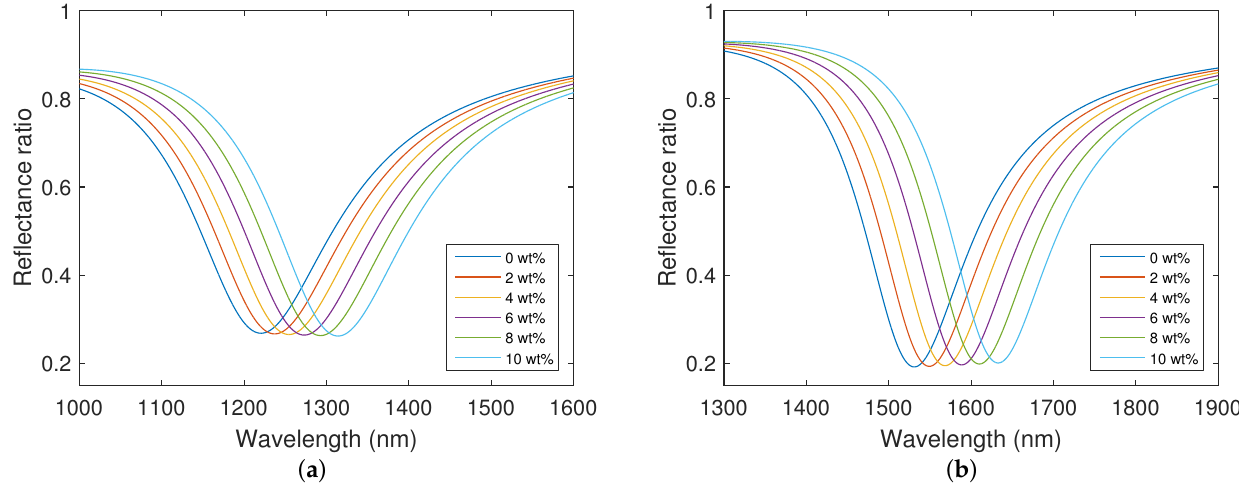
Figure 6. Theoretical spectral reflectance ratio R p ( λ ) / R s ( λ ) for the silicon dioxide layer thicknesses: = 147.5 nm ( a ), t = 270.9 nm ( b ). Angle of incidence θ = 68 ◦ t SiO SiO 2 2